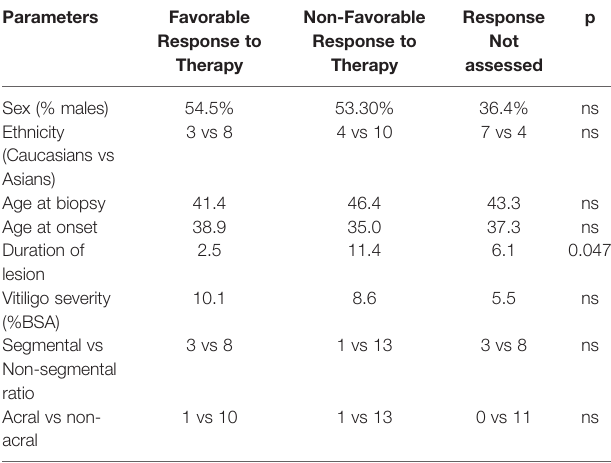
TABLE 2 | Correlational Analysis of Response to NBUVB-Tacrolimus